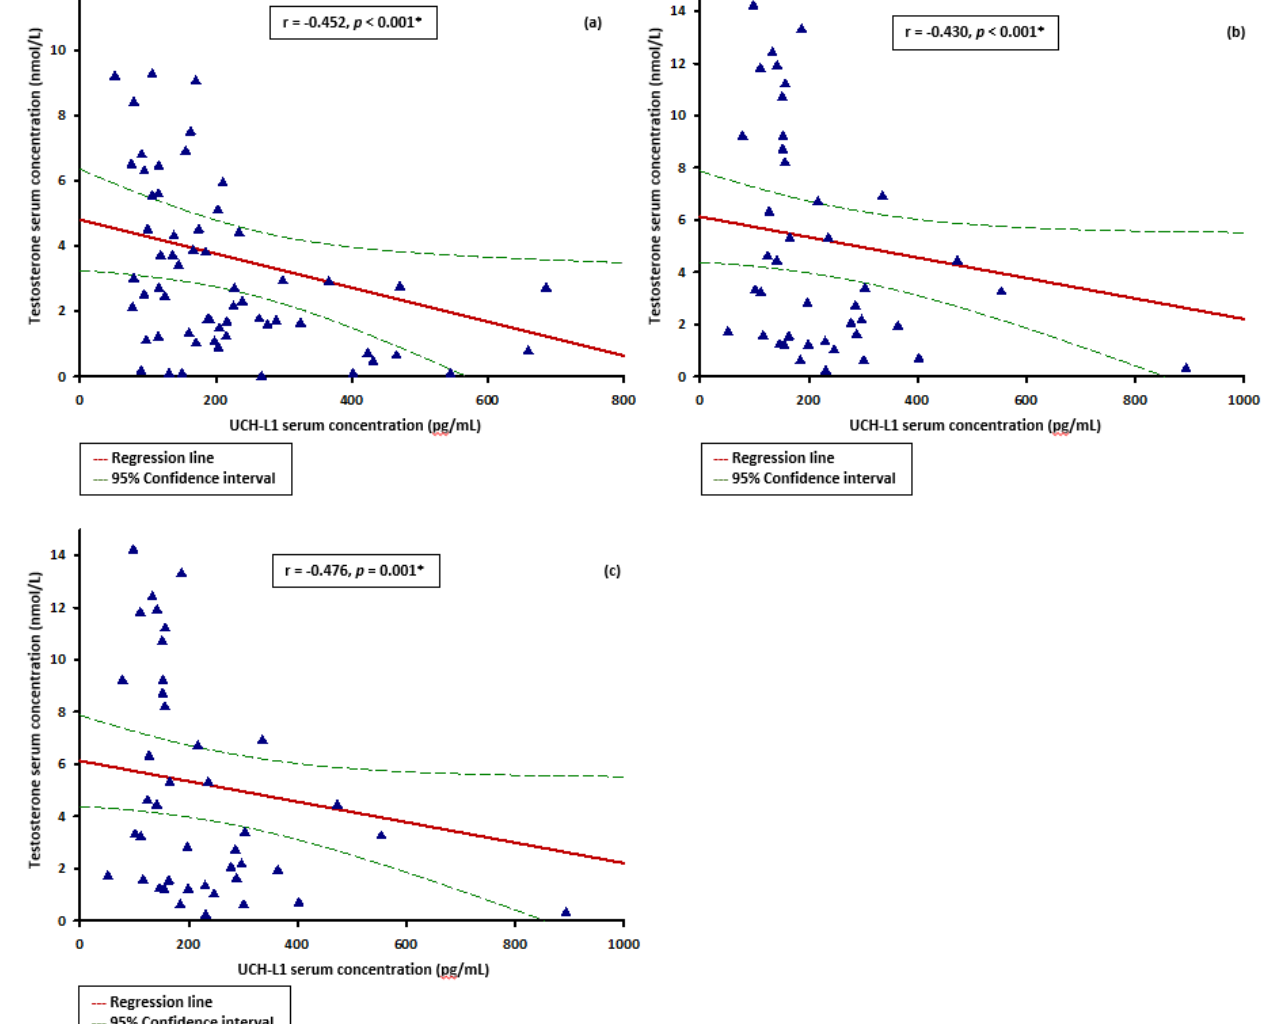
Figure 3. Correlation between UCH-L1 and serum testosterone concentrations at different time points of the ICU stay: ( a ) correlation between UCH-L1 and serum testosterone on admission to ICU; ( b ) correlation between UCH-L1 and serum testosterone 7 days after admission; ( c ) correlation between UCH-L1 and serum testosterone 14 days after admission. Abbreviations: UCH-L1: Ubiquitin carboxy-terminal hydrolase L1; ICU: intensive care unit. * Spearman rank correlation.